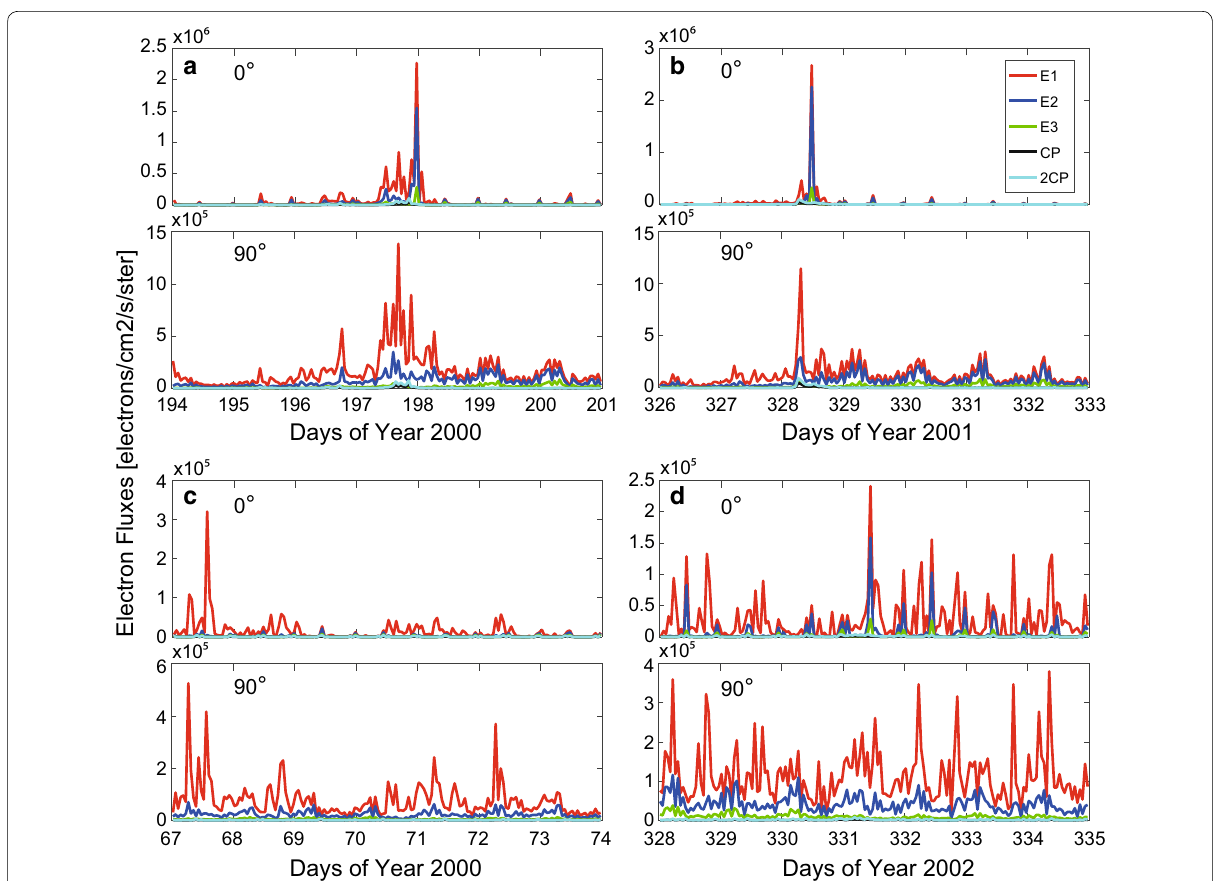
Fig. 1 Variation of electron and proton fluxes during the 7-day interval straddling the anomaly day on a ASCA, b FUSE (1), c ERS-1, and d Radar- sat-1(1). The red, blue, and green curves represent electron fluxes for channels E1, E2, and E3, respectively, and the black and light blue curves indicate the variation of contaminating protons obtained from methods 1 and 2 in sequence